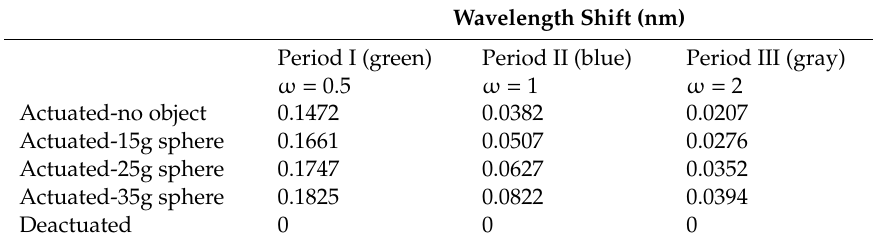
Figure 5. ( a ) Illustration of various FBG embedding sinusoidal period in the gripper arm (red dotted lines indicate the location of the FBG); ( b ) measured optical spectra of FBG corresponding to different events occurring at the soft gripper (i) Period I: ω = 0.5, (ii) Period II: ω = 1, and (iii) Period III: ω = 2. Table 2. Wavelength shift of FBG with different sinusoidal embedding period